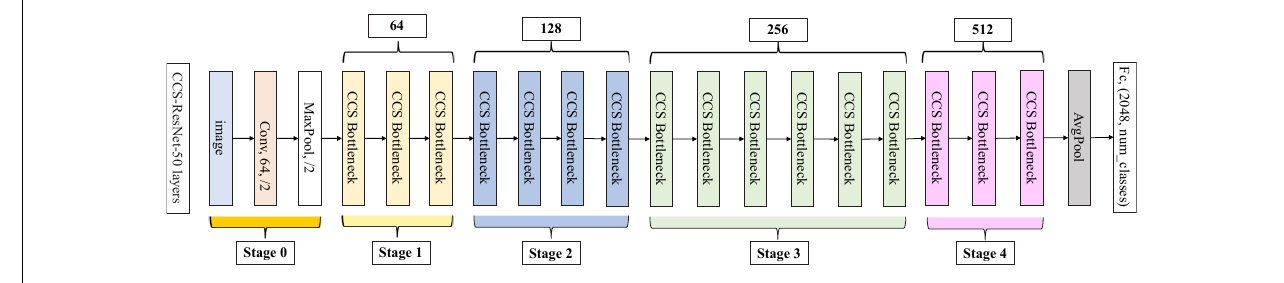
FIGURE 6 | CCS-ResNet-50 architecture diagram. TABLE 2 | Comparison of ResNet-50 and CCS-ResNet-50.